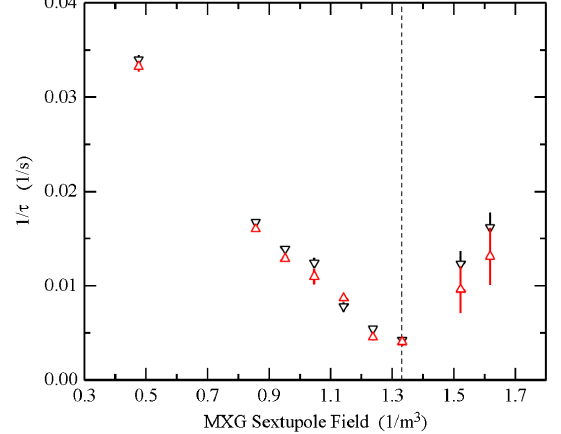
FIG. 21. Measurements made with the long beam of 1 / τ as a function of the G sextupole field (Scan 3). The S field is 1 . 95 m − 3 . The optimum field value is indicated by a dashed line.